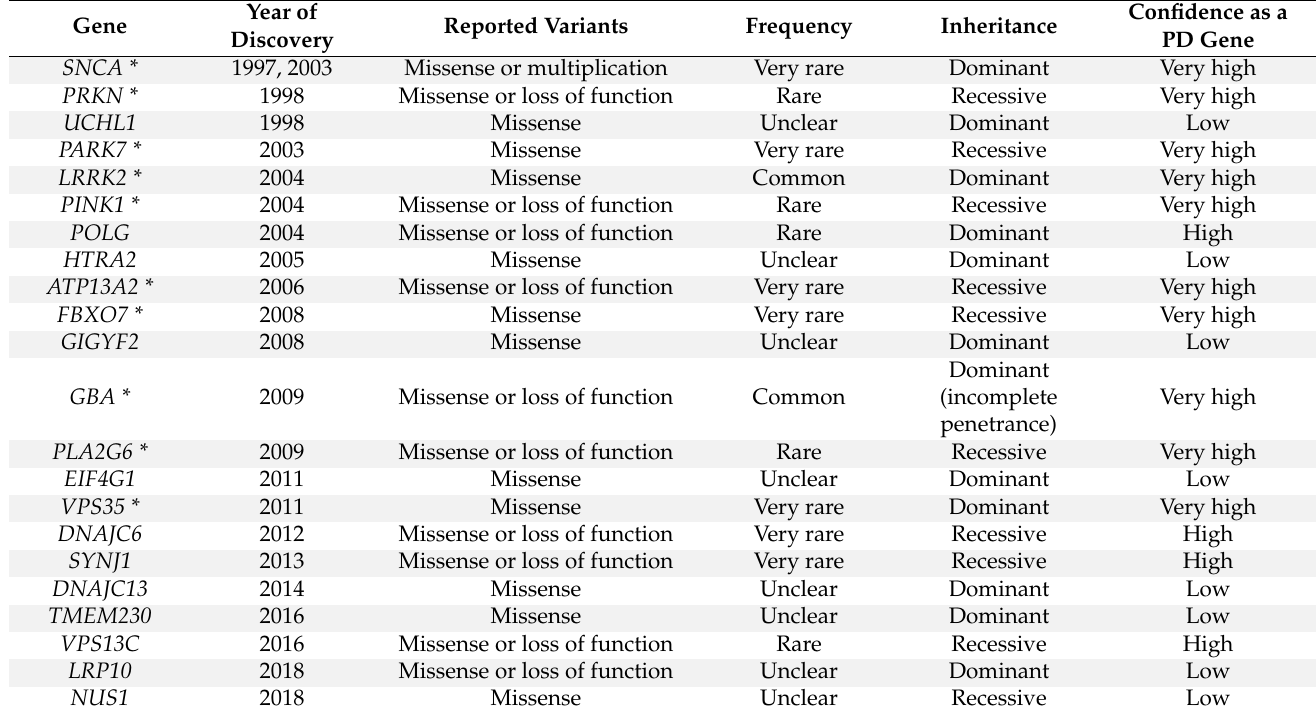
Table 1. List of genes reported to be linked with Parkinson